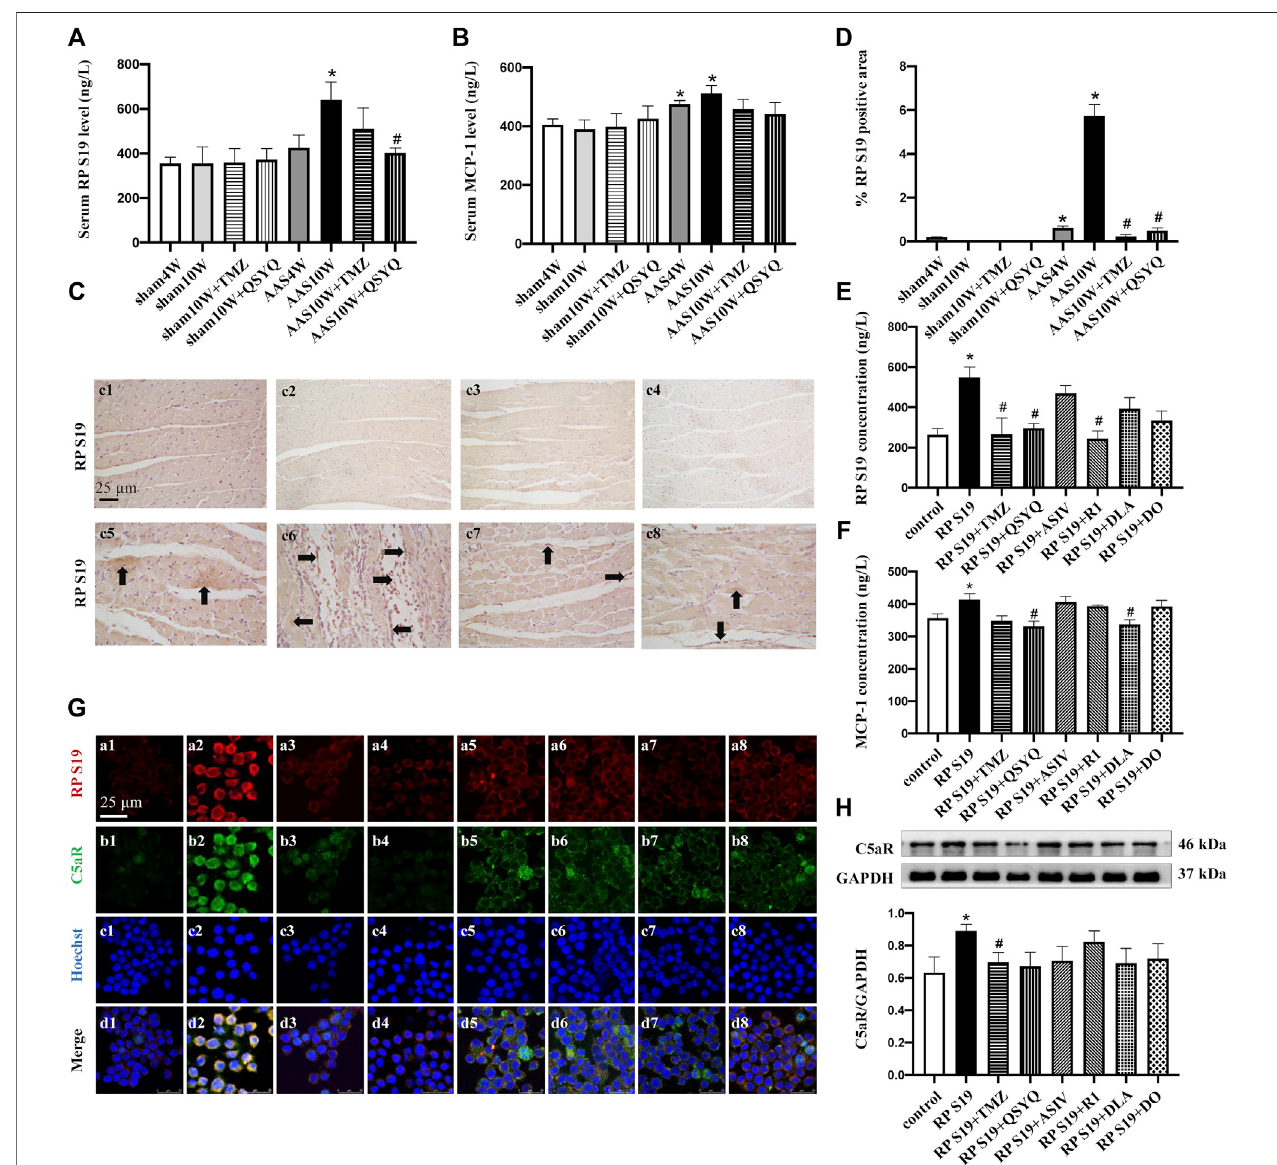
FIGURE 3 | QSYQ reduced the release of chemokine RP S19 and inhibited its colocalization with the C5a receptor. (A,B) Rat serum RP S19 and MCP-1 levels detected by ELISA in rats from different groups. (C) Representative photomicrographs of immunohistochemistry staining for RP S19 in rat myocardium in the Sham4W (c1), Sham10W (c2), Sham10W + TMZ (c3), Sham10W + QSYQ (c4), AAS4W (c5), AAS10W (c6), AAS10W + TMZ (c7), and AAS10W + QSYQ (a8) groups. (D) Quantitative analysis results of RP S19 positive area. Arrows indicate the RP S19-positive area. Bar = 50 μ m. Data are presented as the mean ± SEM, n = 3. (E,F) RPS19andMCP-1levelsdetectedbyELISAintheH9C2cellsupernatants.Dataarepresentedasthemean±SEM, n =4. (G) Immuno fl uorescenceimagesofC5aR,RP S19 and Raw264.7 monocyte nucleus in the control (a1, b1, c1, and d1), RP S19 (a2, b2, c2, and d2), RP S19 + TMZ (a3, b3, c3, and d3), RP S19+ QSYQ (a4, b4, c4, and d4),RPS19+ASIV(a5,b5, c5,andd5),RPS19+R1(a6,b6, c6,and d6),RPS19+DLA(a7,b7, c7,andd7),and RPS19+DO(a8,b8,c8,and d8)groups. Scale bar = 25 μ m. Dataare presented as the mean ± SEM, n = 3. (H) Western blotting analysis ofRaw264.7monocyte C5aR. Data are presented asthe mean ± SEM, n =